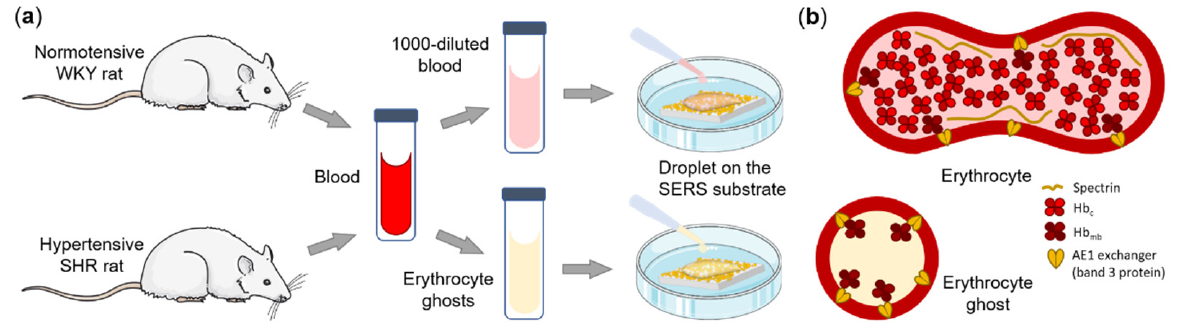
Figure 1. Schematic illustration of ( a ) the experimental design and ( b ) cross-sections of an erythrocyte and an erythrocyte ghost demonstrating the non-homogeneity of hemoglobin molecules in the submembrane region of erythrocytes and the homogeneity of hemoglobin bound to AE1-exchanger in erythrocyte ghosts-enclosed vesicles of erythrocyte plasma membrane.